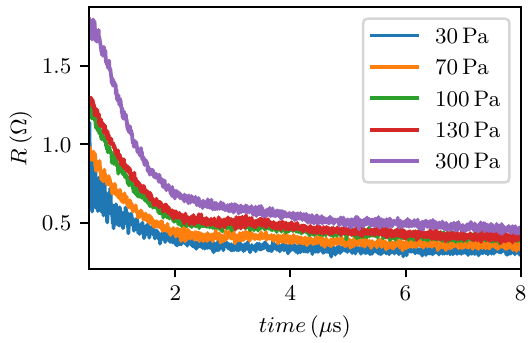
Figure 3. Time dependencies of resistance measured for various initial